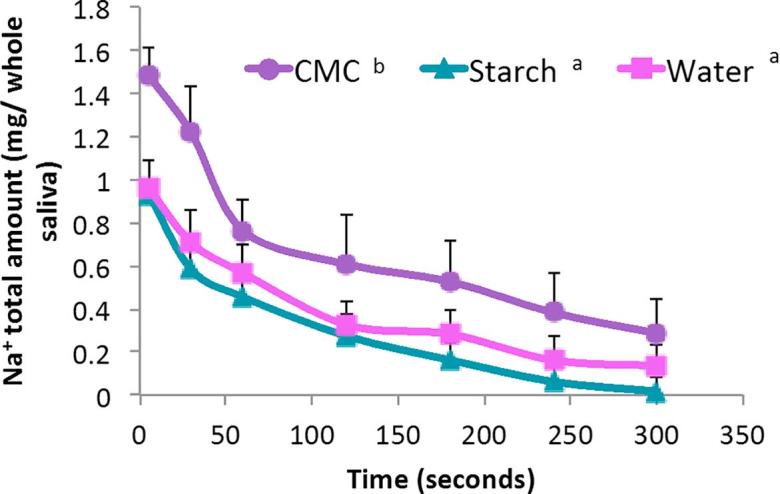
Amount of sodium present in participants’ whole saliva over 5 min. Each data point represents the mean of 15 (5 participants, 3 repeats) saliva collections analysis. Each sample presented to the participants contained 9 mg Na+, therefore, the first data point on this graph represents the residual sample left in the mouth after participants swallowed the sample. Error bars represent ±standard error mean. The letters next to the sample key represent statistically significant groupings. Different letters represents a significant difference of p < 0.05 using Bonferroni correction.